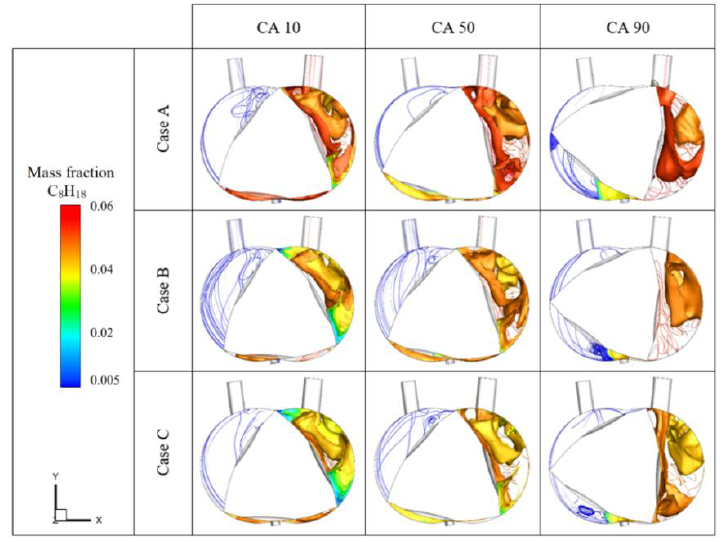
Figure 14. Streamlines and iso-surfaces of C 8 H 18 mass fraction in the Wankel engine for different cases at CA 10, CA 50 and CA 90.